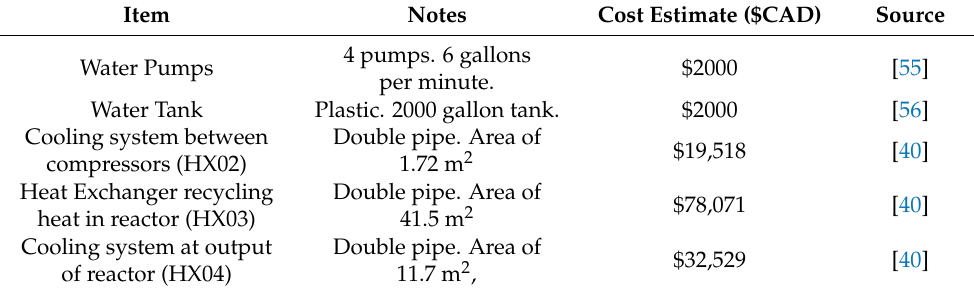
Table 3. Miscellaneous Items Capital